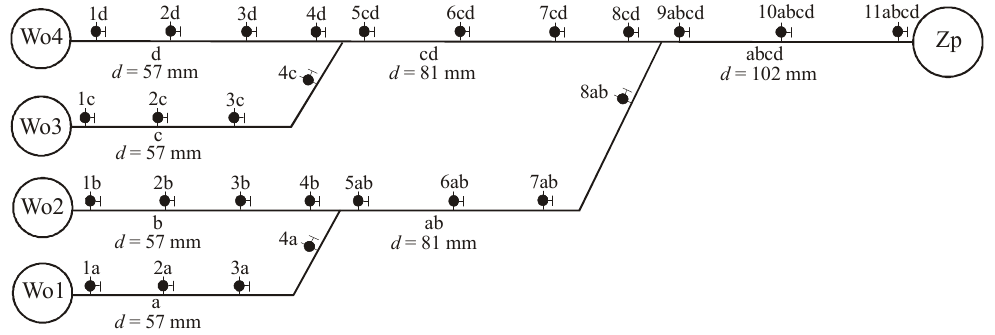
Figure 6. Expansion of the experimental installation of vacuum sewerage acc. Figure 2: 1a, …, 11abcd—measuring points on the vacuum pipeline; Wo1, …, Wo4—emptying knot; Zp—vacuum container; a, …, abcd—vacuum pipelines; d = 57 mm—vacuum pipeline internal